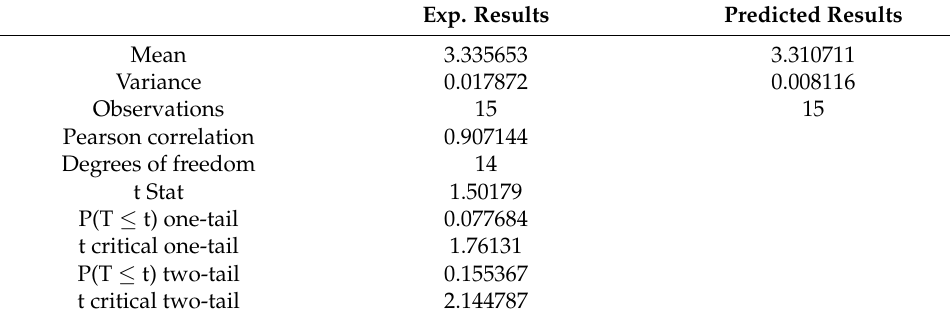
Table 10. T -test for compressive strength